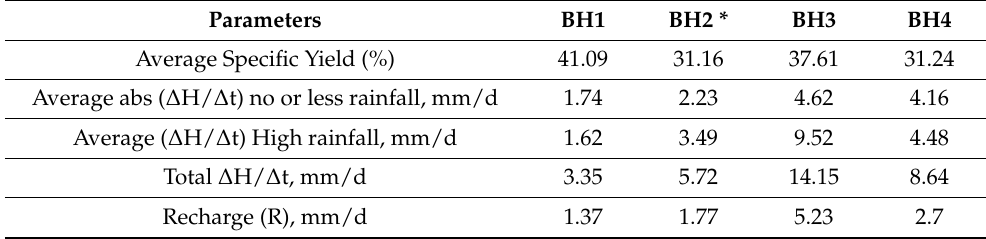
Table 3. Specific yield values and calculation of recharge. Parameters